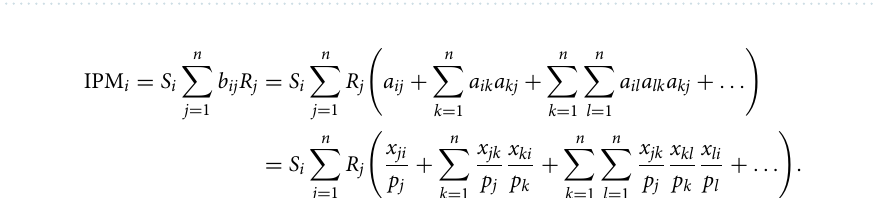
Figure 1. A simulation study to demonstrate the potential propagation of interactions via transportation network